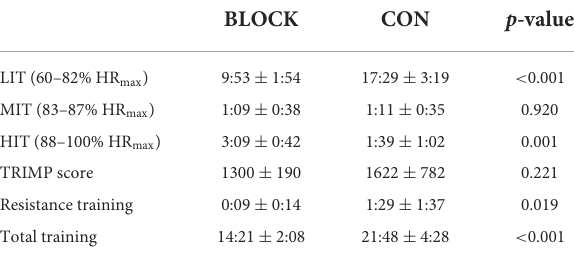
TABLE 1 Training data for the HIT block group (BLOCK) and the control group (CON) during the intervention period. BLOCK CON p